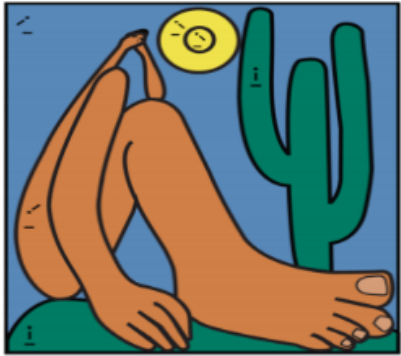
Figure 2. Abaporu adapted as a tactile picture using the See Color code. Source: Ribeiro, 2019.